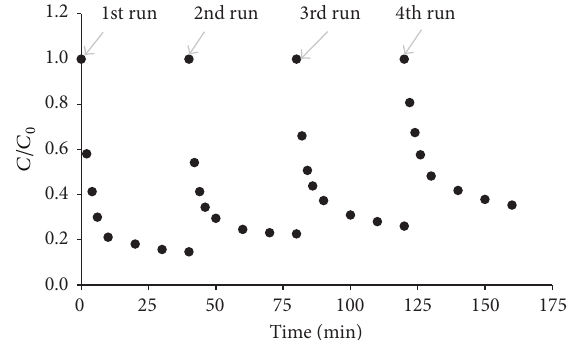
Figure 7: Catalyst reusability during four cycles using 100 mgL −1 of 37.4 mg/g Fe 2 O 3 catalyst calcined at 500 ∘